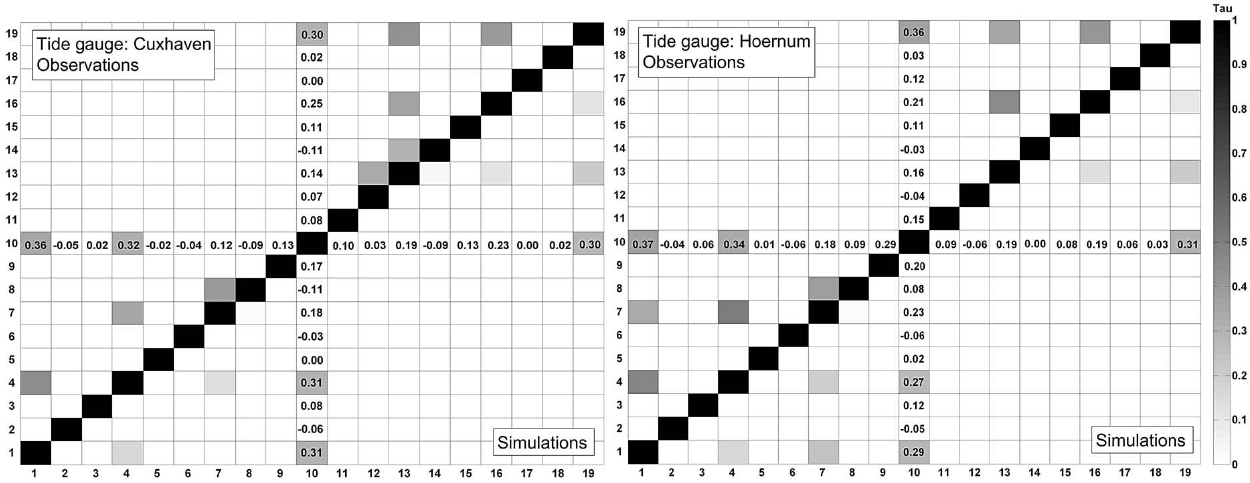
Fig. 11. Rank correlation matrices for the 19 sea level parameters from the observations (upper left triangles) and the simulation results (lower right triangles) for the tide gauges of Cuxhaven (left) and H¨ornum (right). The values for τ between parameter 10 and all other parameters are written as numbers, as these relationships are considered to account for interdependencies as described in the text.